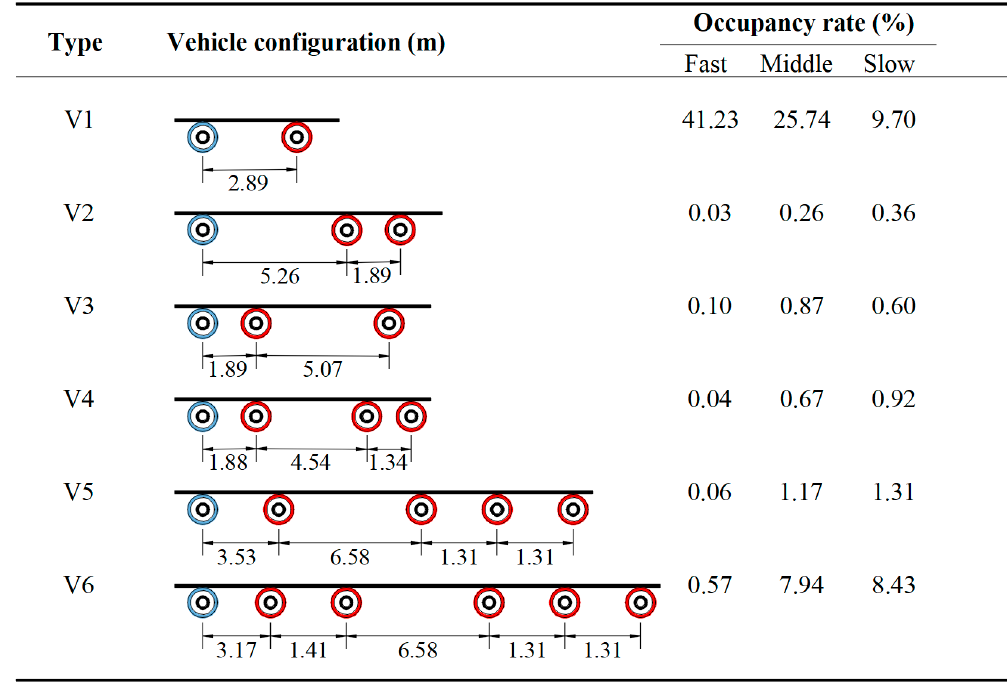
Figure 11. Vehicle category and occupancy rate [41].